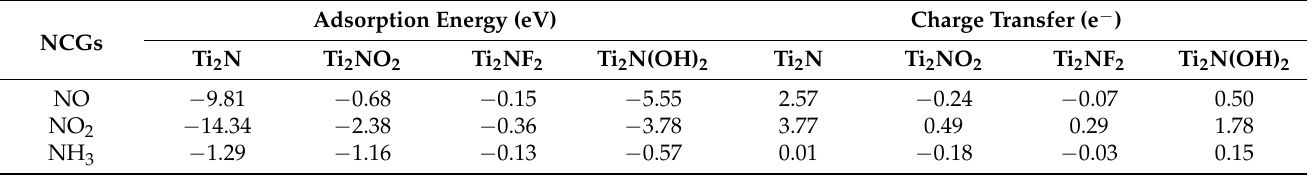
Table 1. Adsorption energy (E ads ) and charge-transfer profiles of NCGs adsorption on 2-D Ti 2 N and Ti 2 NT 2 (T=O, F, OH).